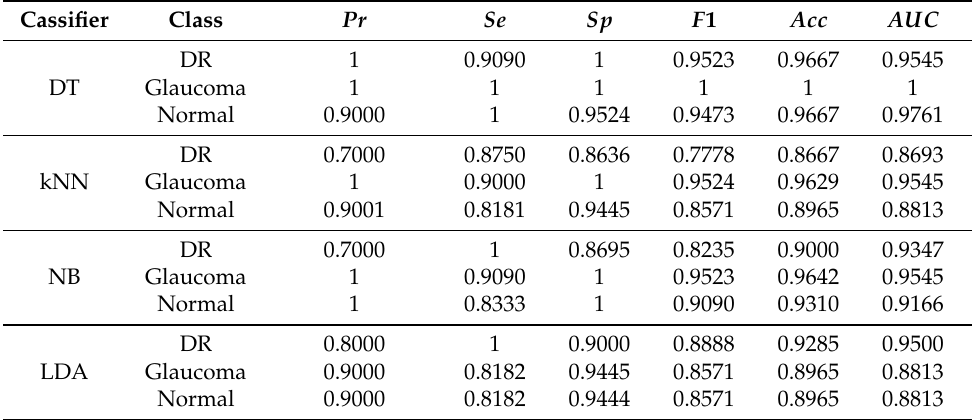
Table 6. Classification performance per classifier for every class in Dataset_2.